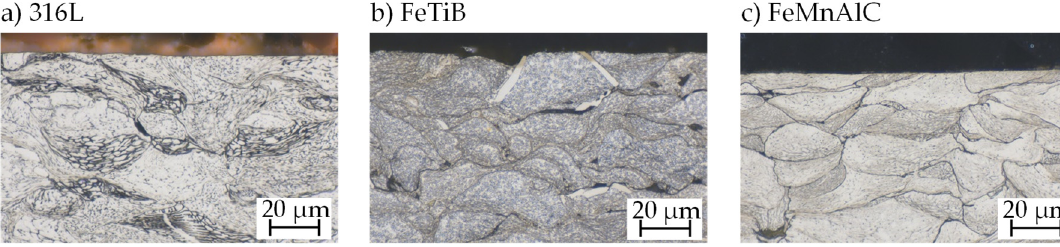
Figure 7. Microstructure after milling: ( a ) etched 20 s in 60% electrolytic HNO 3 (1.5 V); ( b , c ) etched 15-20 s in 3% alcoholic HNO 3.